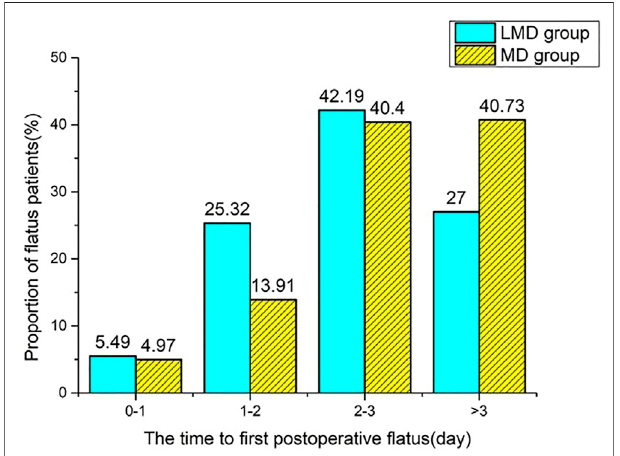
FIGURE 3 | Change trend of Dex plasma concentration. The plasma concentration of the LMD group was signi fi cantly higher than that of the MD group, which lasted until 8 h after the operation , p < 0.05. “ ↓ ” : end of the operation. “ * ” : blood drug concentration at each time point during operation. “ # ” :theplasmaconcentrationat2,4,6,and8 haftertheoperation.